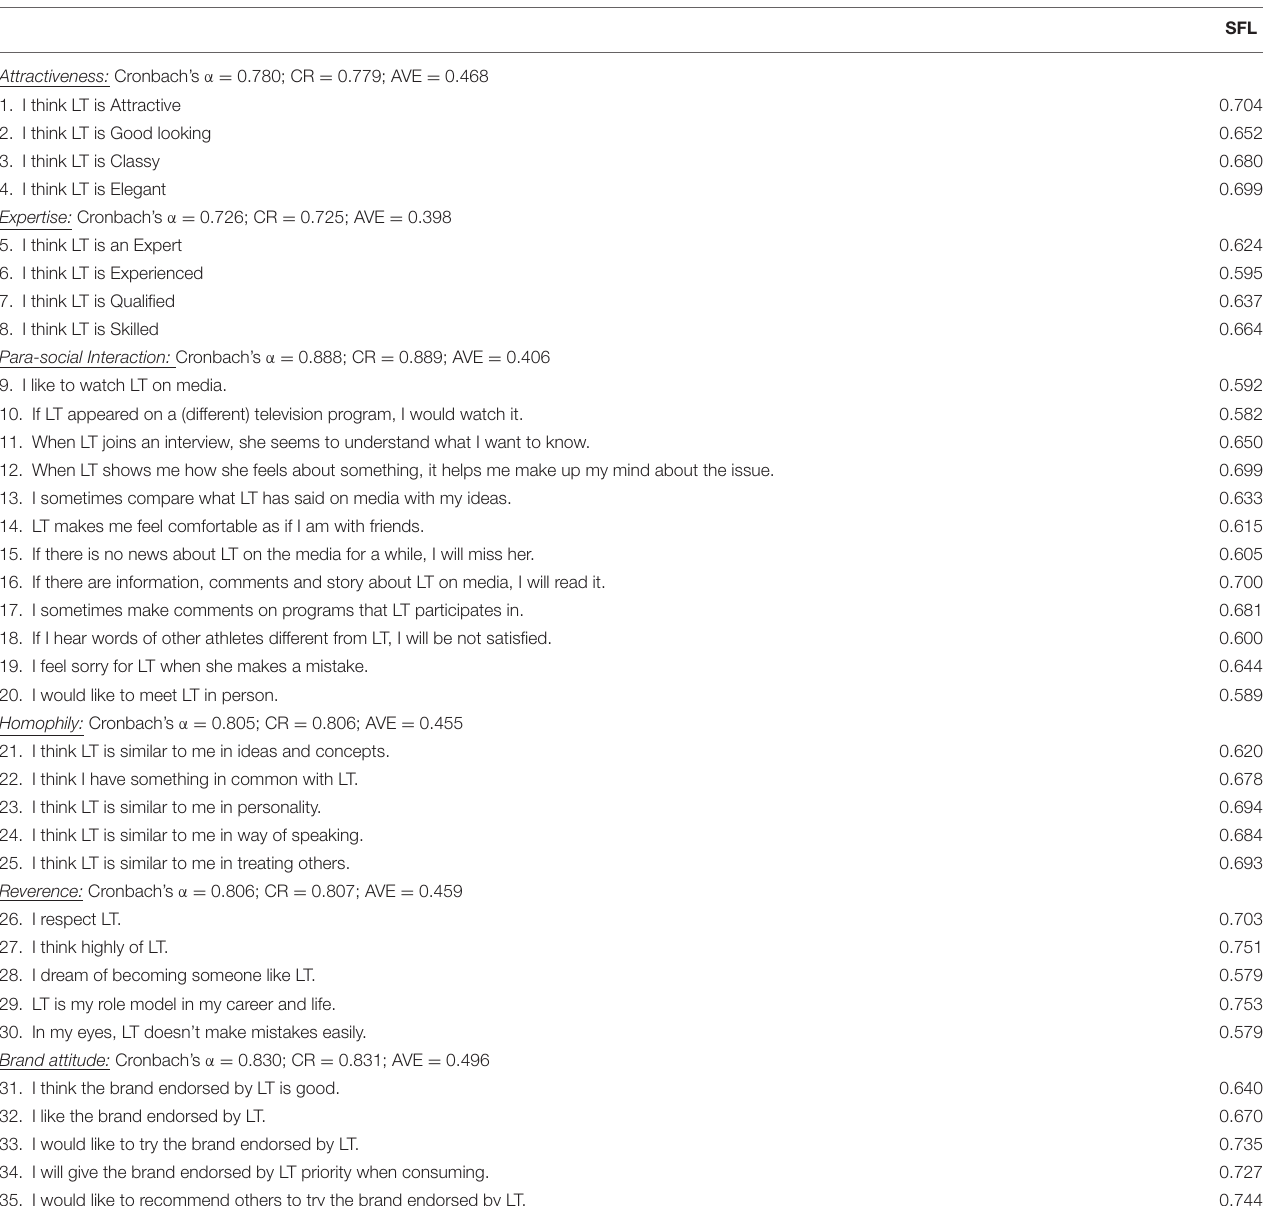
TABLE 1 | Measurement items and reliability and validity